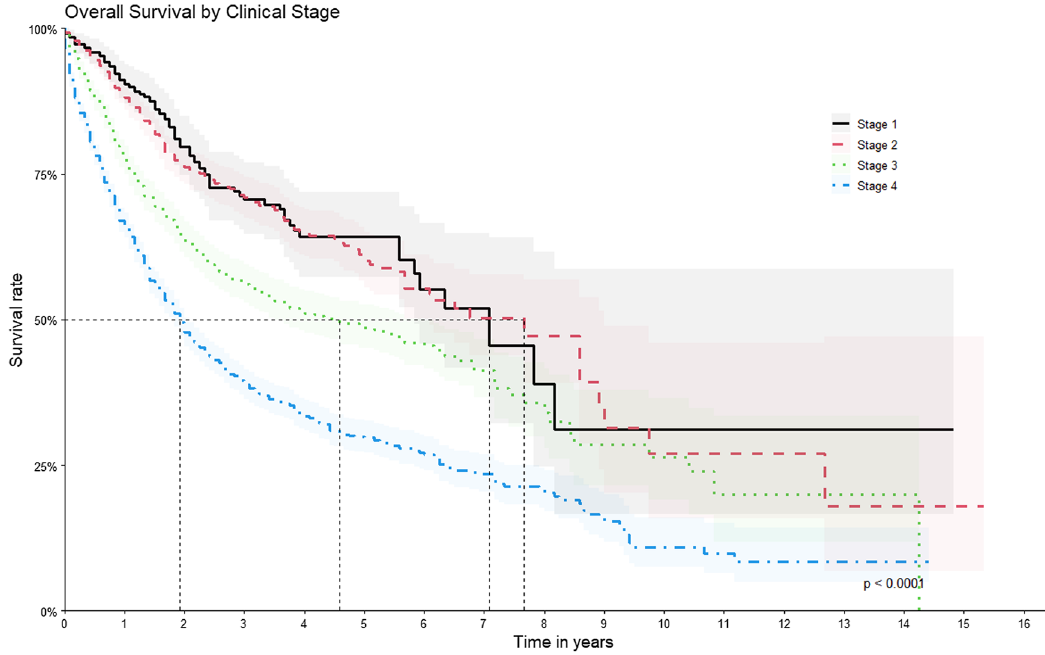
Figure 4. Overall Survival by Clinical Stage. Anatomic location type of